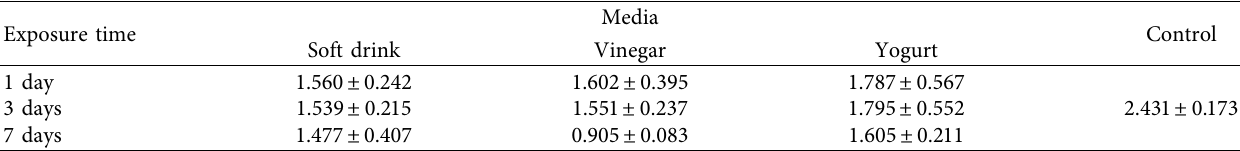
Table 4: Crystallinity index intensity ratio at 1030/1020 (mean ± SD) for dentin of tooth samples after exposure to different media at variable times, including the control group.